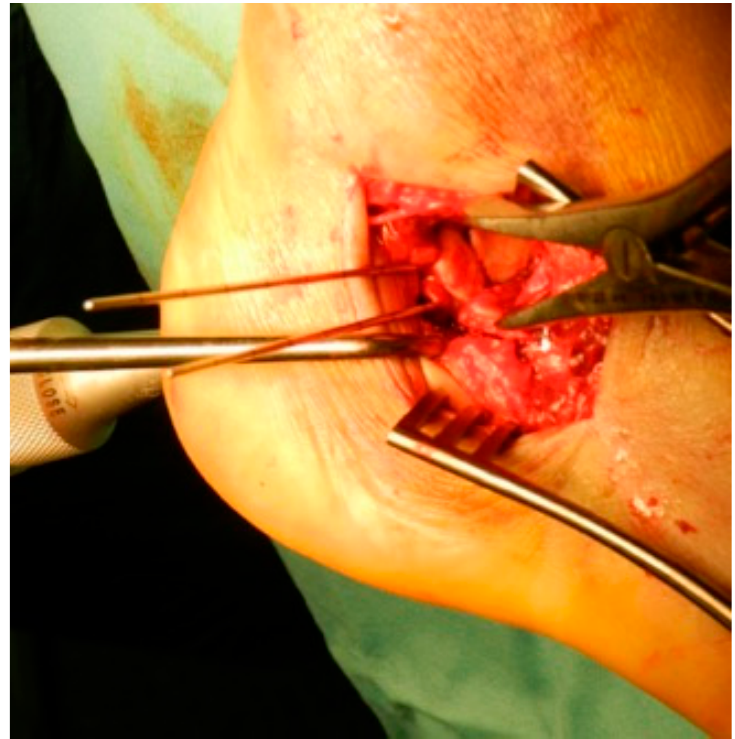
Figure 2. Reduction of the fragments with provisional fixation with K-wires.